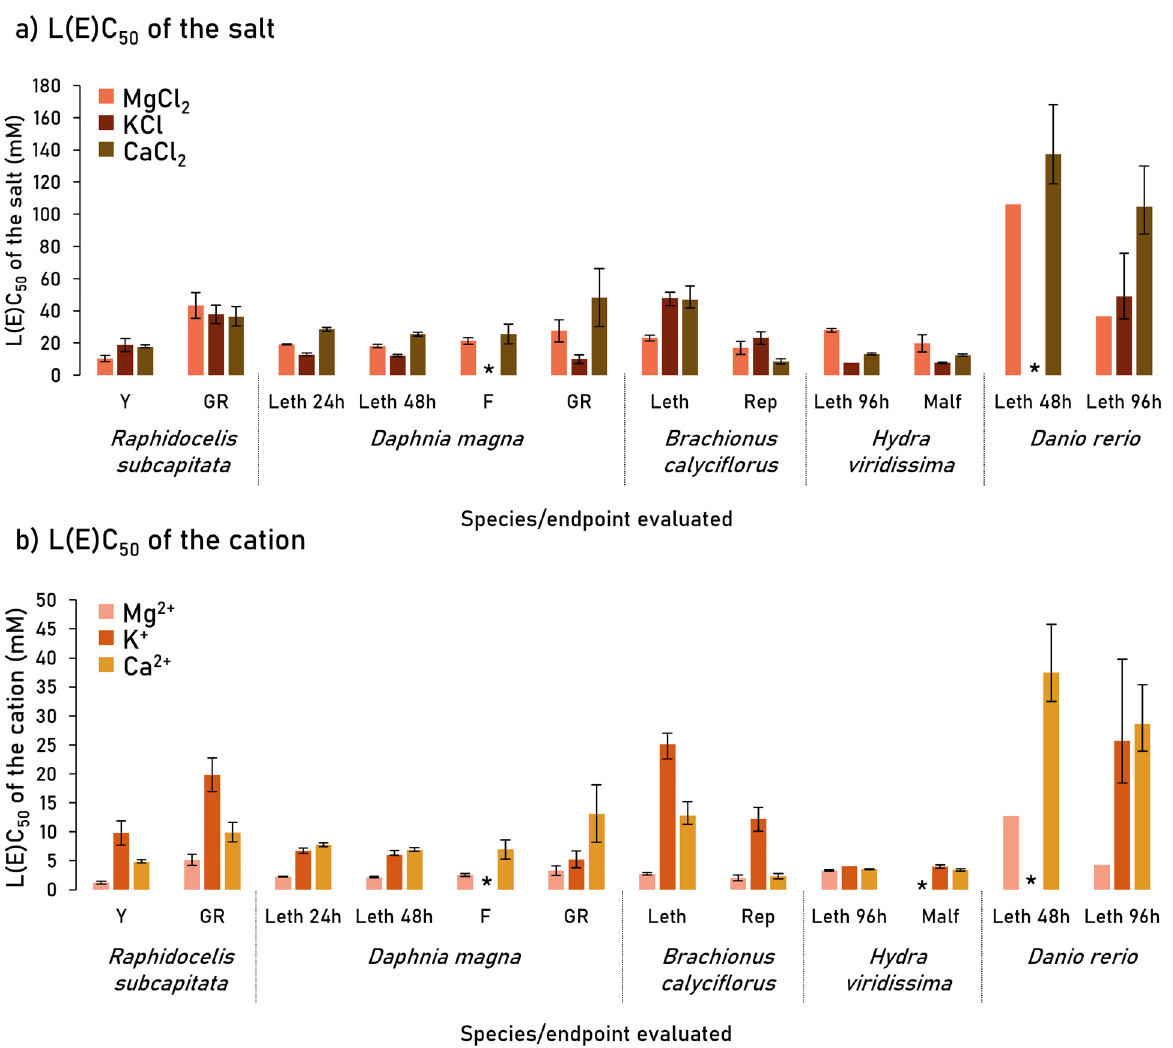
Figure 1. Median lethal and sublethal concentrations (mM) determined for ( a ) magnesium chloride (MgCl 2 ), potassium chloride (KCl), and calcium chloride (CaCl 2 ) salts and ( b ) the correspondent concentrations of each salt cation (Mg 2+ , K + , or Ca 2+ ). Vertical bars correspond to the 95% confidence limits. * indicates that the parameter could not be estimated. Abbreviations stand for: Y—yield;